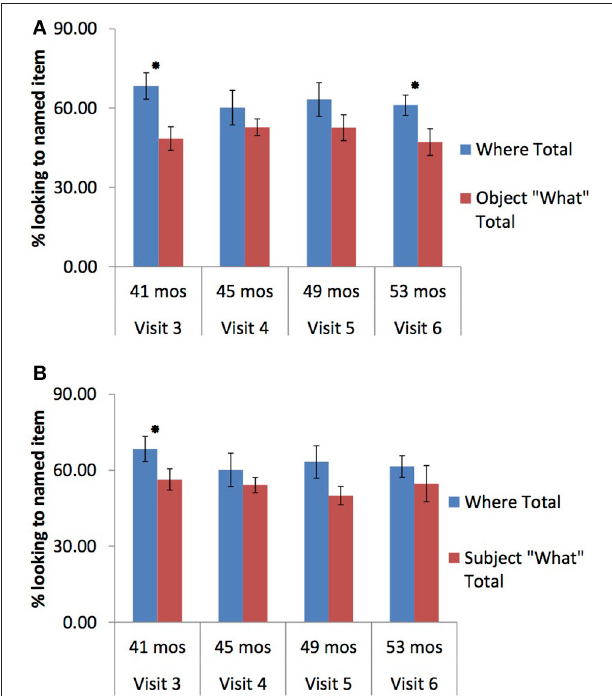
FIGURE 2 | (A) Comparism of where vs. object what trails for Children with ASD across visits. * p < 0.05. (B) Comparism of where vs. subject what trails for Children with ASD across visits. * p < 0.05.